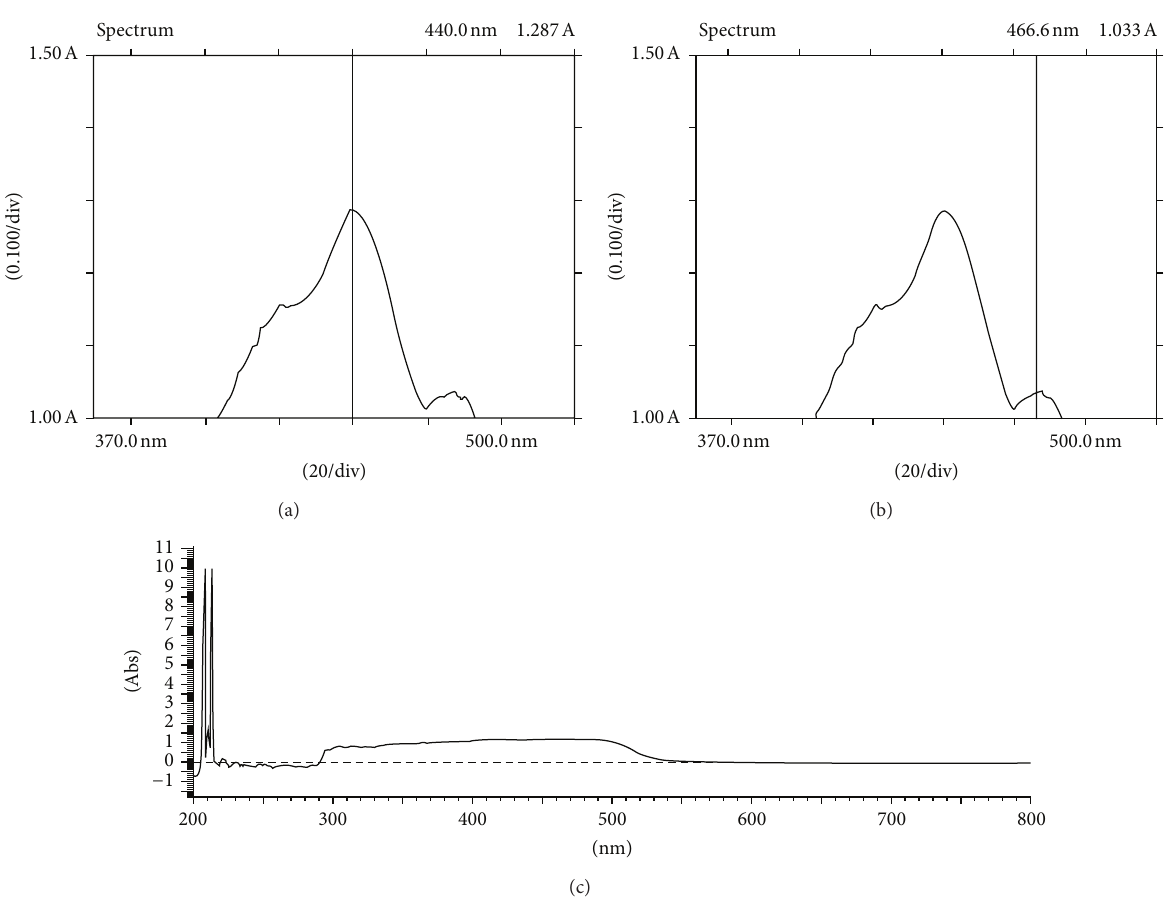
Figure 1: Absorbance spectrum of 𝛽 -carotene/ 𝛼 -carotene pigments isolated from crude palm oil: (a) absorbance maxima of 𝛽 -carotene at 440nm; (b) absorbance of 𝛼 -carotene at 466.6 nm; (c) absorbance profile of 𝛽 -carotene/ 𝛼 -carotene mixture in a crystalline